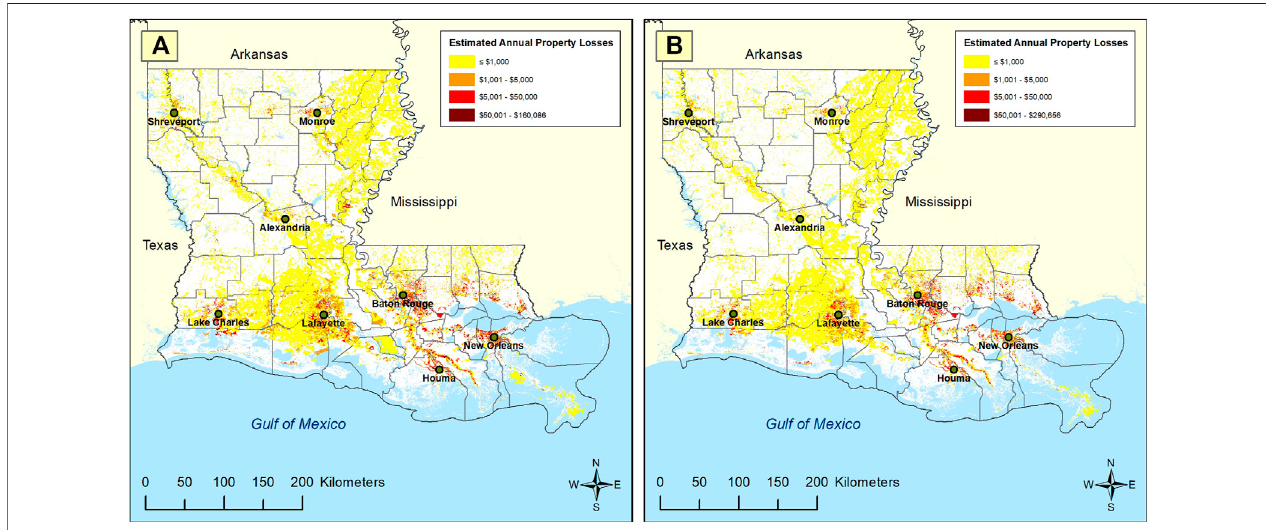
FIGURE 3 | Estimated annual property loss (2010$) due to expansive soil by Louisiana census block: (A) historical, and (B) projection for 2050.